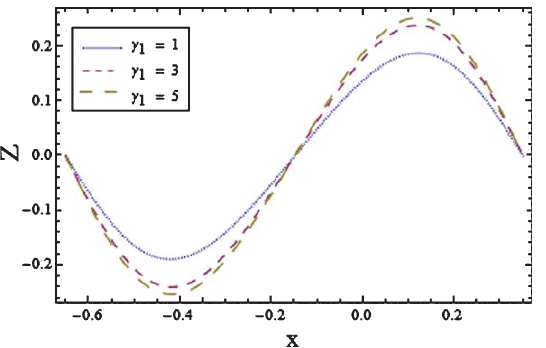
Fig. 21. Plot of heat transfer coefficient Z for various values of the Schmidt number Sc with (cid:15) = 0 . 1, t = 0 . 1 , Sr = 2 , Du = 2 , γ = 1 , γ = 10 , Pr = 1 . 5 and γ = 8 . 1 2